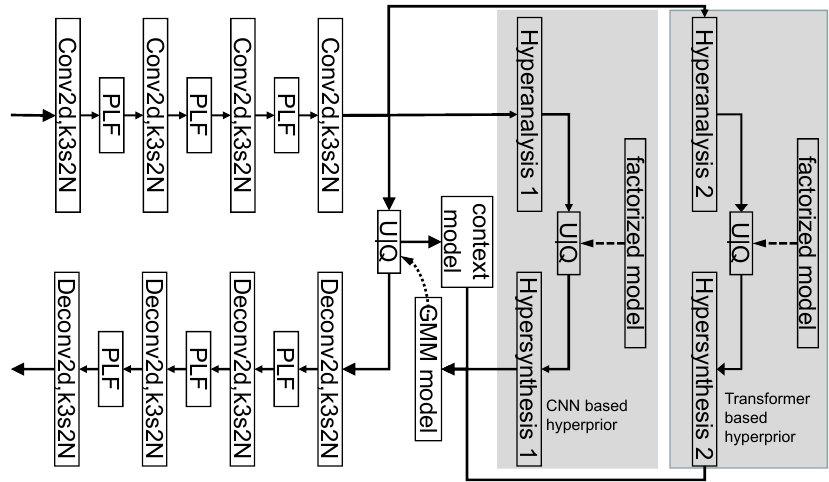
Figure 3. The framework of the proposed compression algorithm.